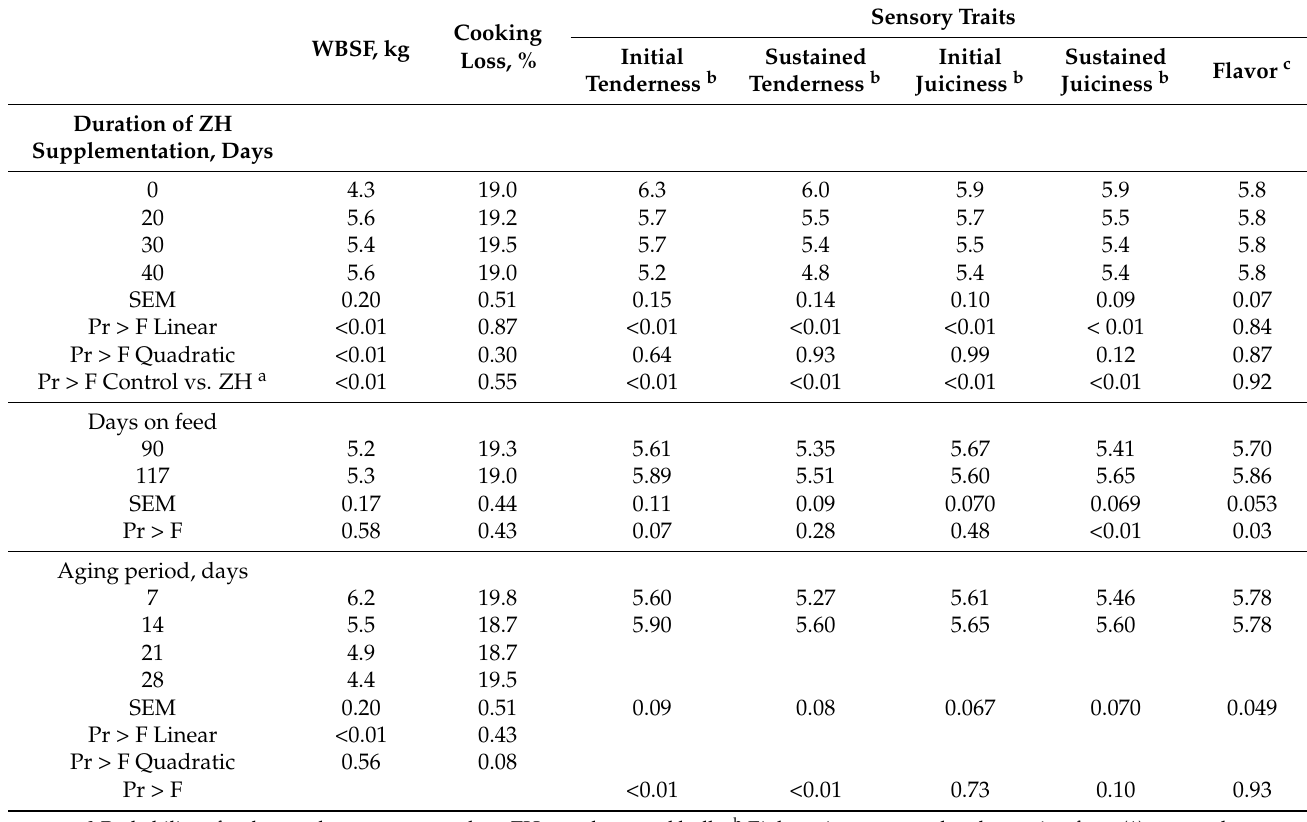
Table 5. Least square means, standard error of the mean (SEM), and probabilities of the Warner–Bratzler shear force (WBSF), cooking loss, and sensory attributes of meat samples according to the duration of zilpaterol hydrochloride (ZH) supplementation, days on feed, aging period, and days on